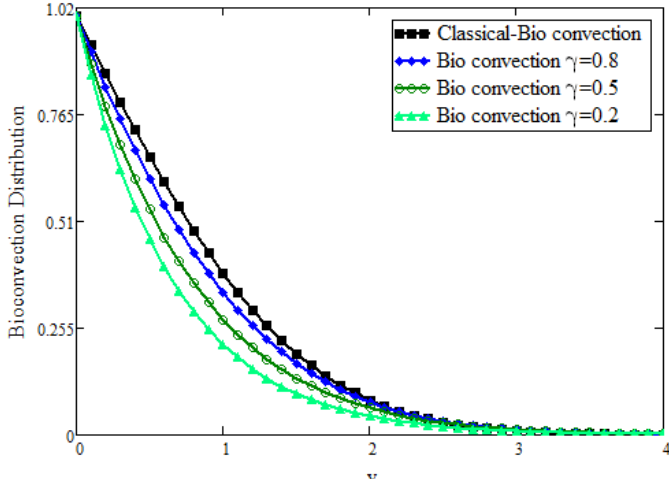
Figure 7. Comparative analysis of bioconvection distribution for different γ values.